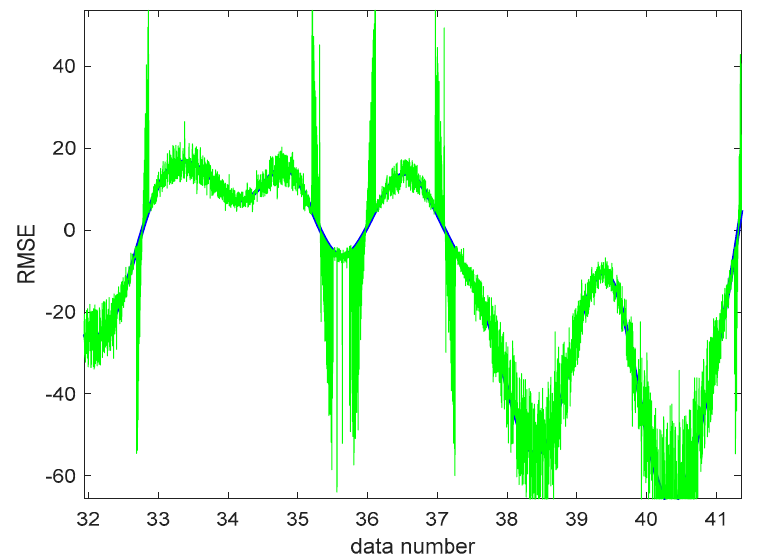
Figure 10. RMSE of the ANFIS-SVM. Table 3. The regression output for self-healing soil-cementitious hydrogel materials in mine backfill in both phases.